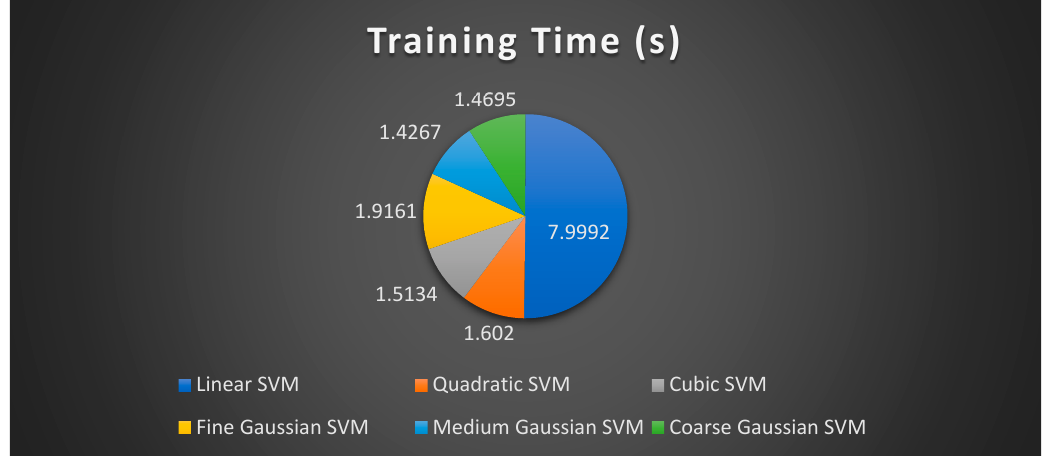
Figure 4. Demonstrated training time of 250 features.